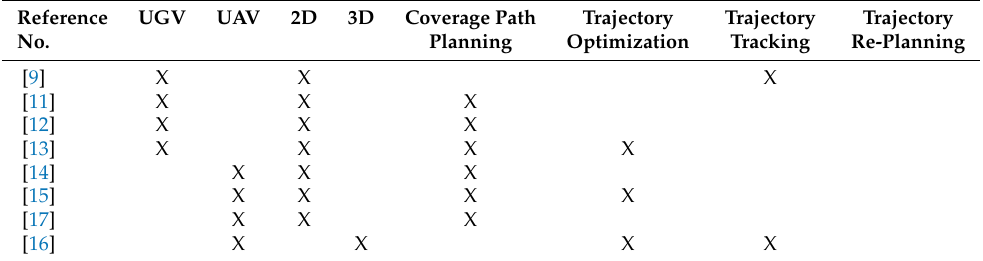
Table 1. The GNC problems solved by the mentioned